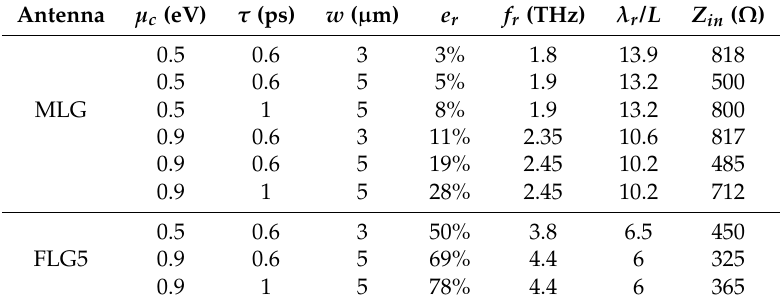
Table 1. Radiation efficiency ( e r ), resonant frequency ( f r ), miniaturization factor ( λ r / L ), and input impedance ( Z in ) of MLG antennas and FLG antennas with five layers (FLG5) for different